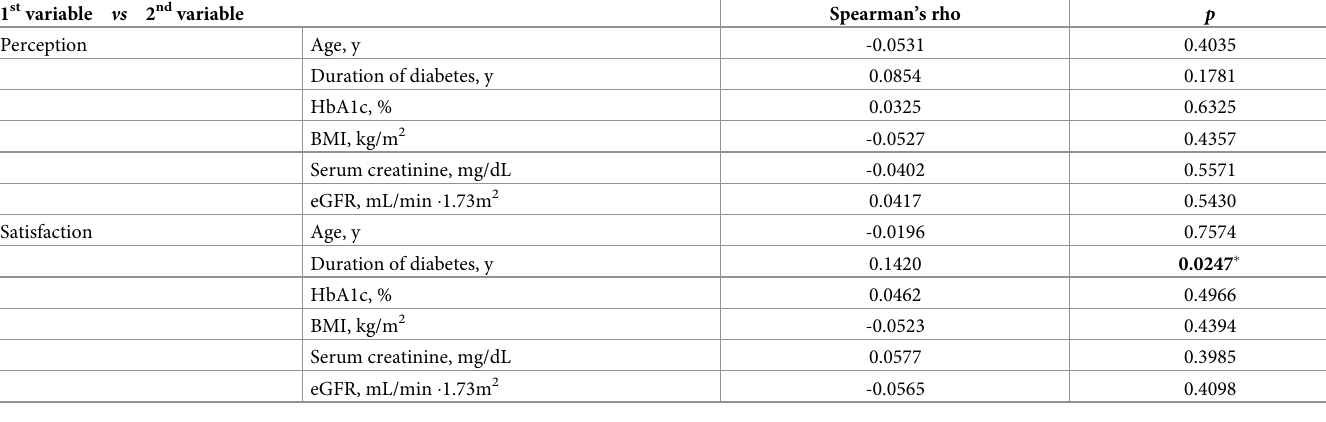
Table 2. Correlation between scores (1 to 5) obtained for “Perception” and “Satisfaction” versus the variables considered. 1 st variable vs 2 nd